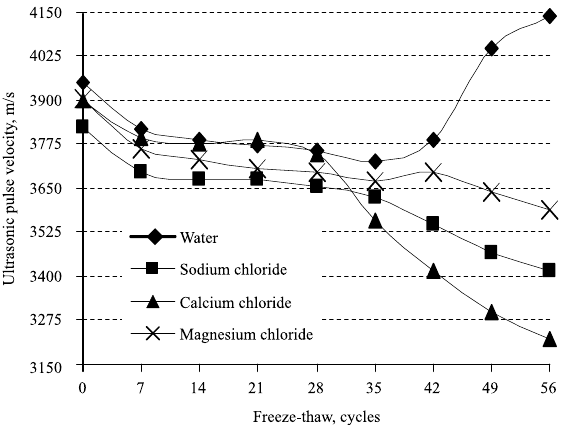
Fig. 3. Kinetics of ultrasonic pulse velocity in specimens made of Portland cement after 56 freeze-thaw cycles in different saline solutions